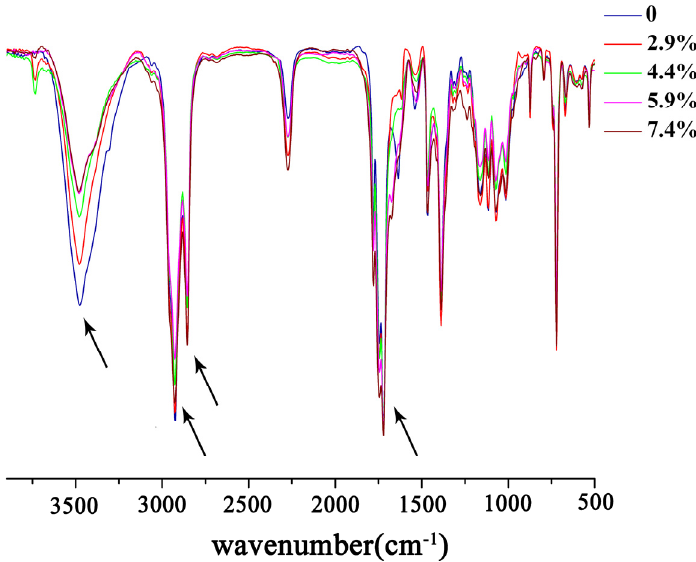
Figure 1. FT-IR spectra of N -phthaloyl acylated chitosan with different crosslinking